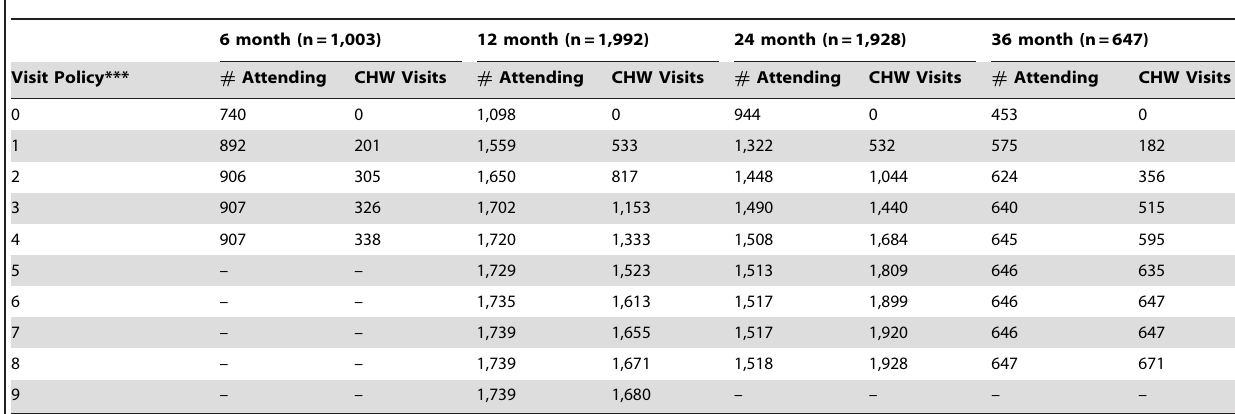
Table 1. Relationship of attendance and CHW visits *,**